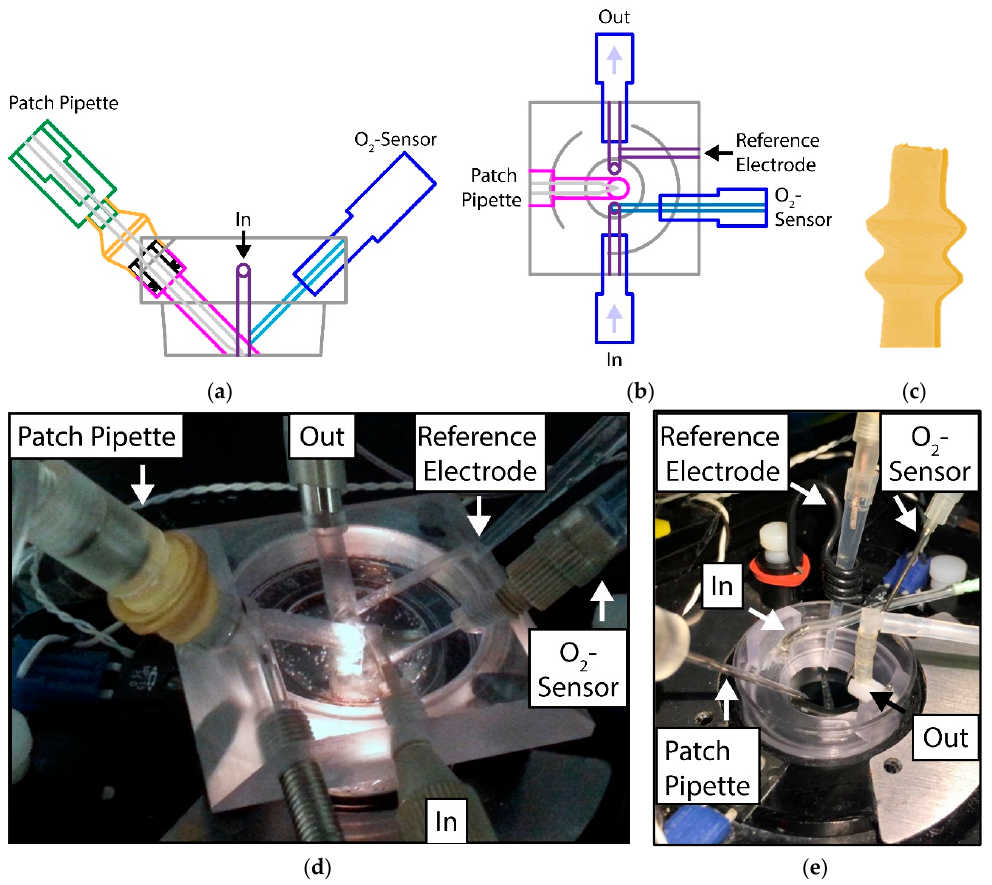
Figure 1. Side view ( a ) and eagle view ( b ) of the CAD drawing of the microfluidic system; ( c ) photograph of the flexible latex glove; ( d ) the closed and ( e ) open system are shown with all components attached. In: Inflow, Out: Outflow.